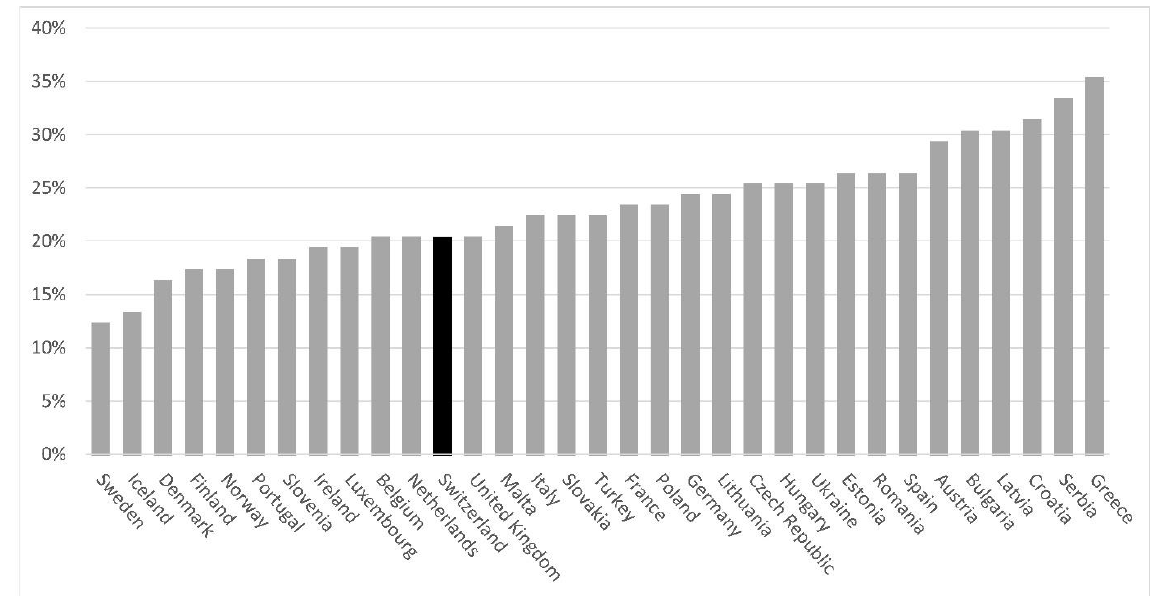
Figure 1: European countries ranked by adult daily smoking prevalence in 2013. Source: WHO Report on the Global Tobacco Epidemic, 2015